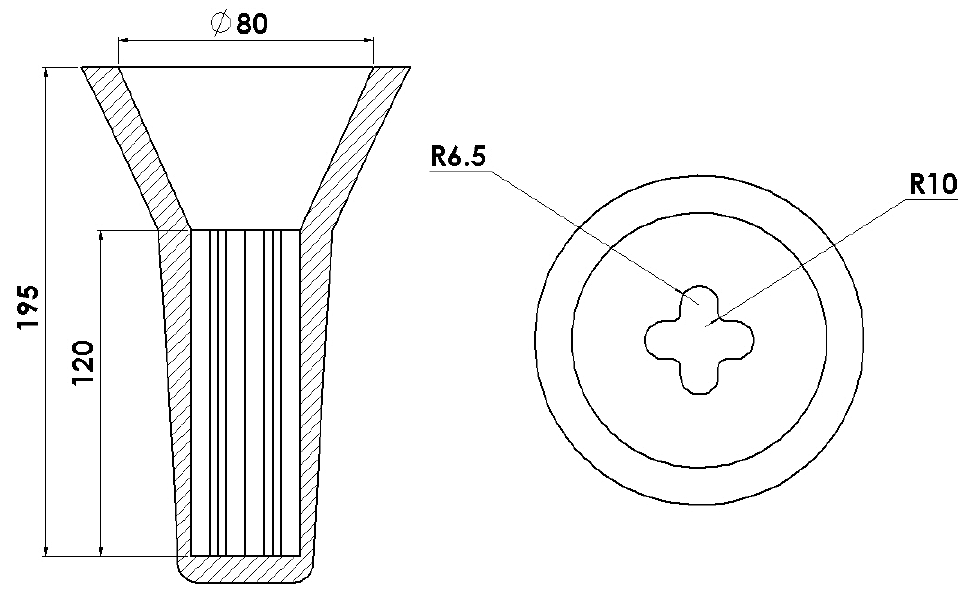
Figure 1. The geometry of the shell mold used for the castings preparation.